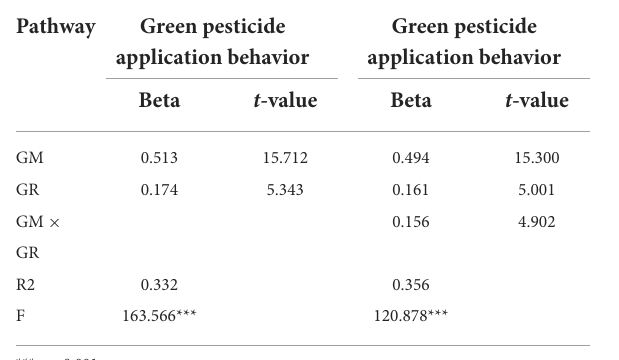
TABLE 10 Government supervision and regulation test.